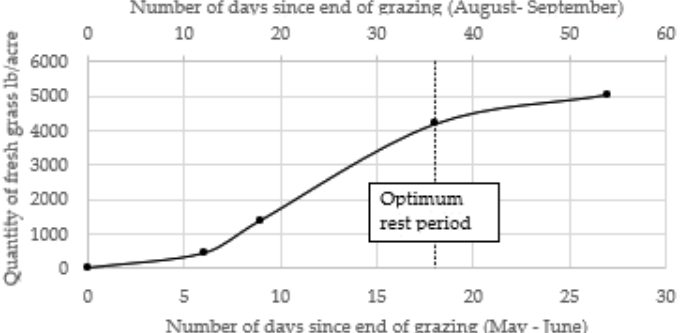
Figure 1. The curve of re–growth in the grass. Source: Adapted from [11].